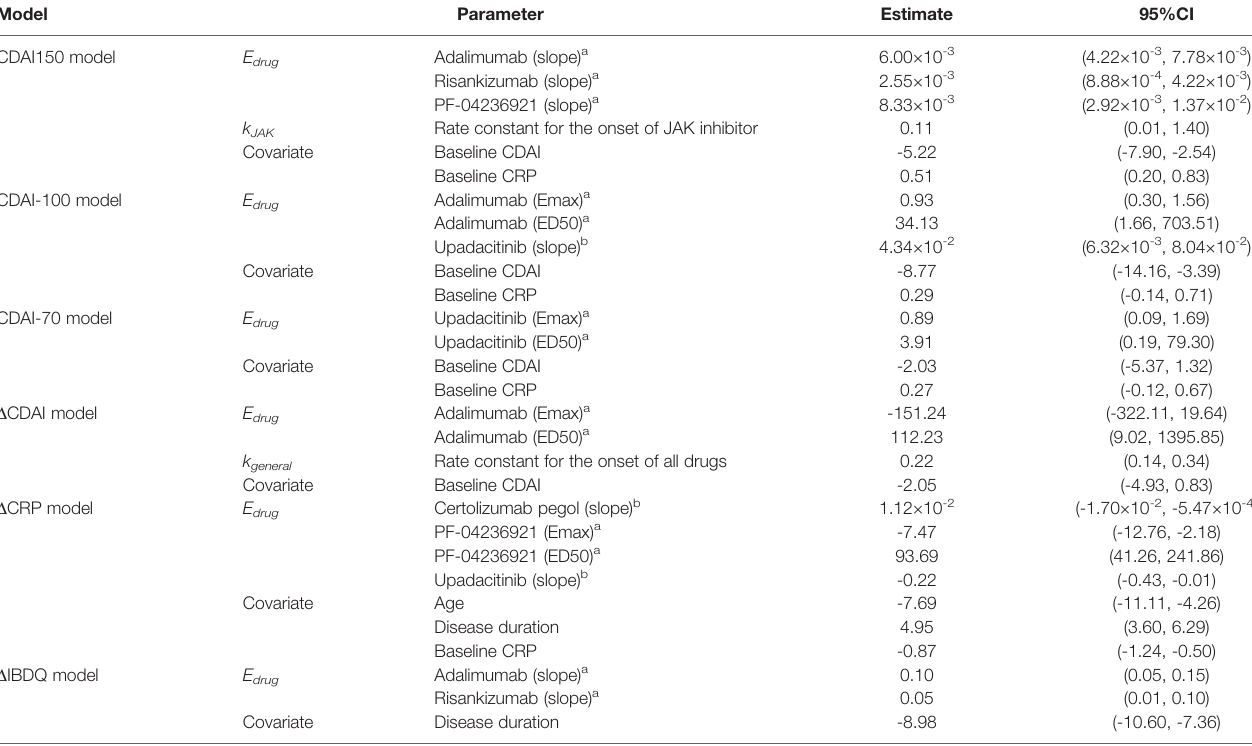
TABLE 2 | Estimate of key parameters in fi nal